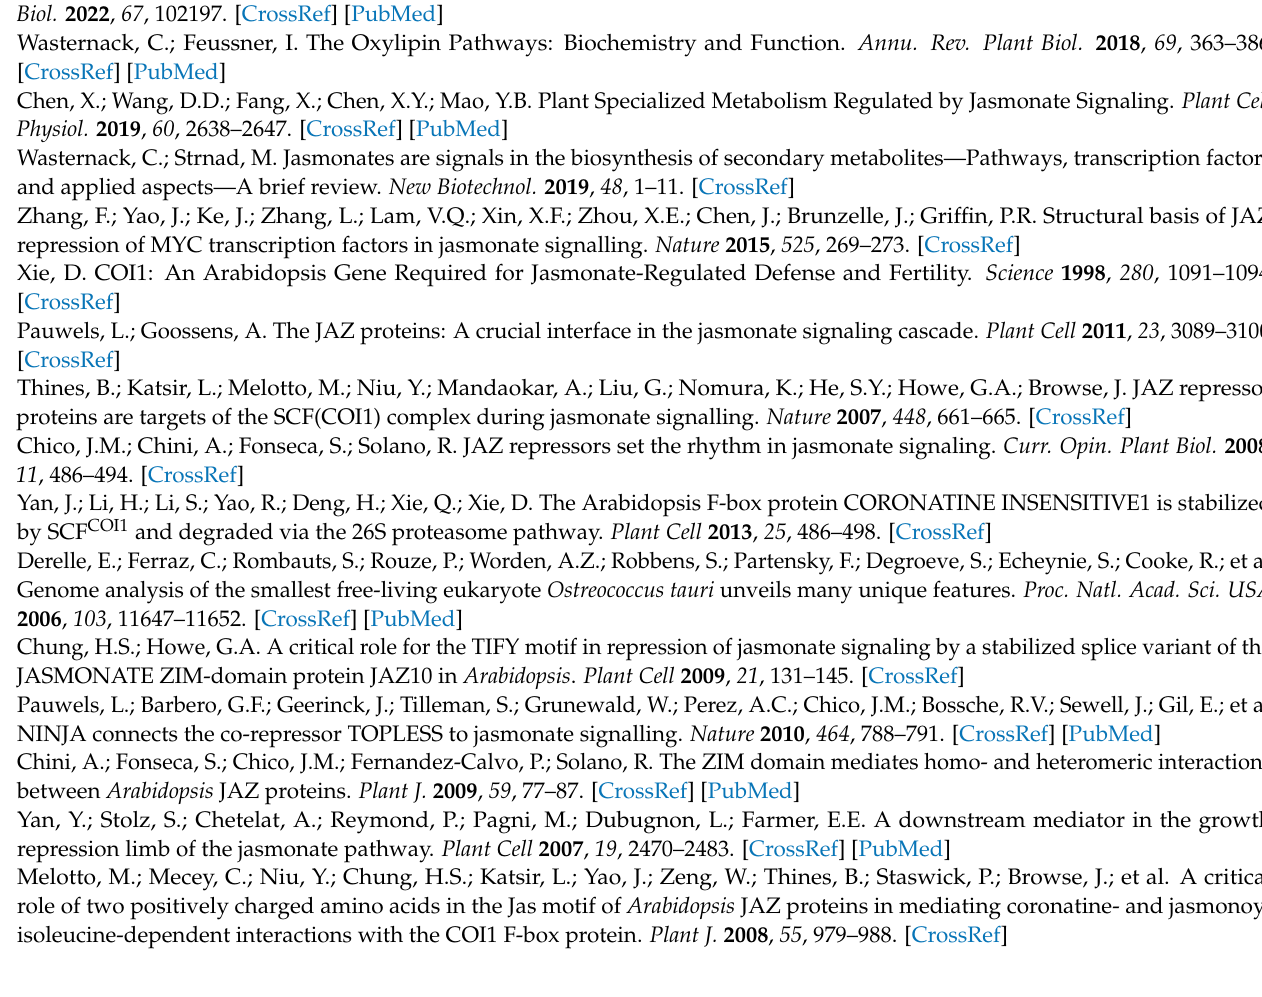
sions; Table S1: Gene-specific primers sequence of qRT-PCR; Table S2: Features of 102 JAZ proteins in B. rapa , B. oleracea and B. napus